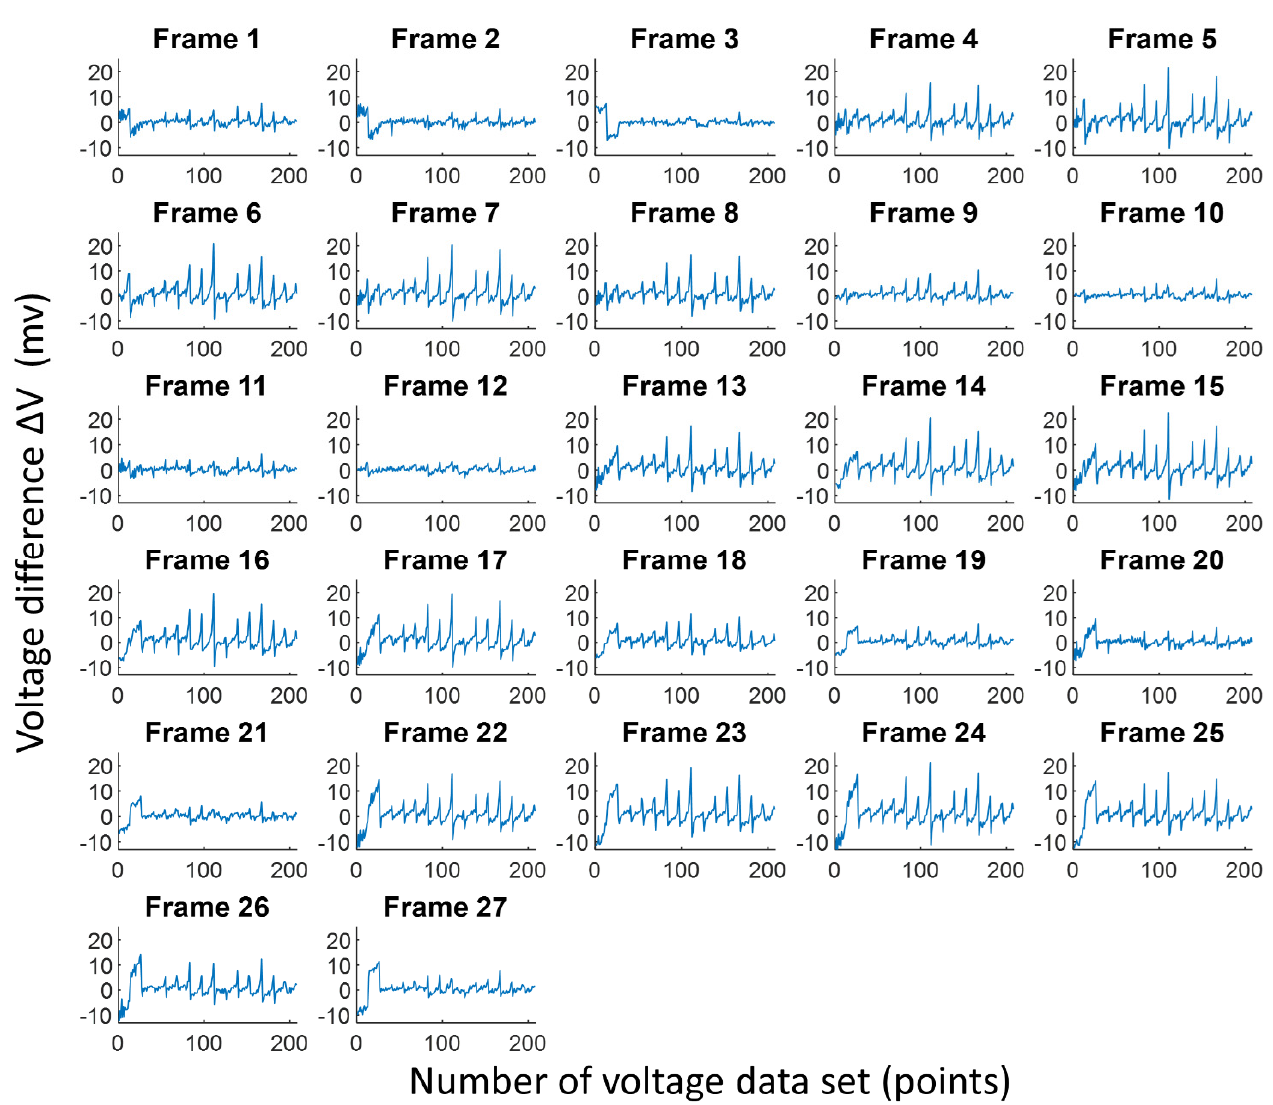
Figure 11. The difference of the reference voltage with the measurement voltage from 27 lung electrical impedance tomography data using a wearable textile-electrode belt.